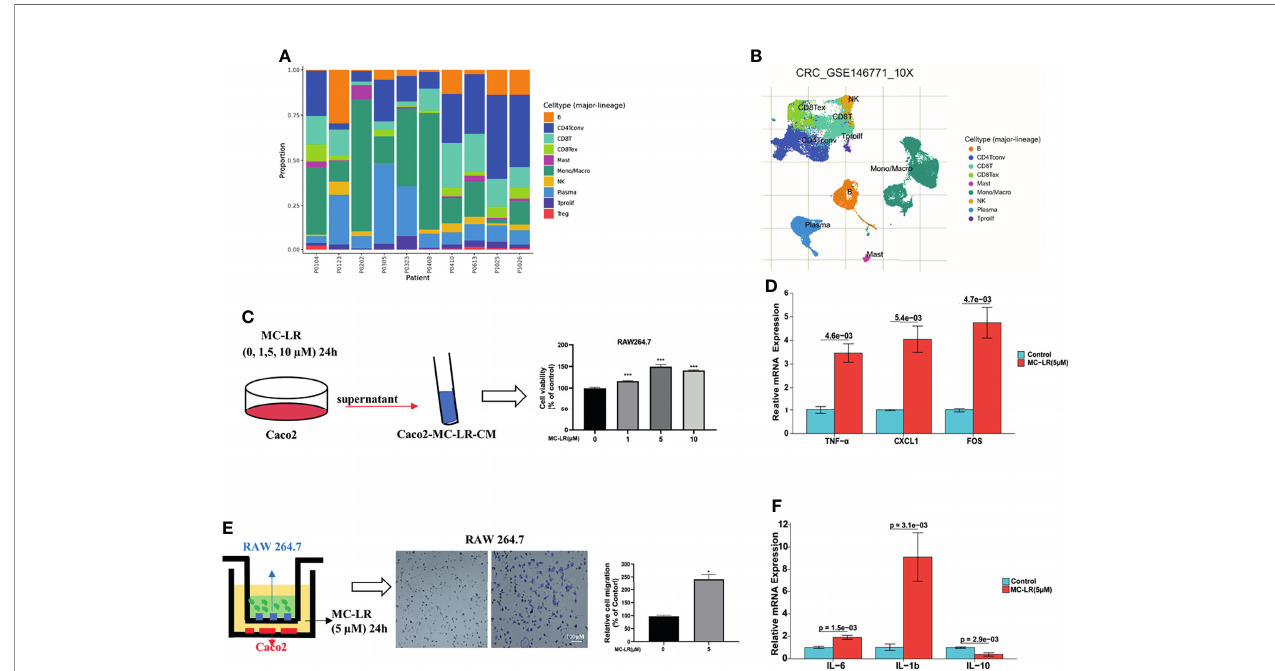
FIGURE 9 | MC-LR-induced interaction between Caco2 and macrophages promoted macrophages proliferation and migration. (A, B) UMAP and bar charts re fl ected the cellular composition of the tumor microenvironment in CRC samples by TISCH. (C) The proliferation of RAW264.7 cells induced by MC-LR with CRC cells through CCK8 assay; *** P <0.001. (D) The migration of RAW264.7 cells were induced by MC-LR with CRC cells through Transwell assay; *P < 0.05 . (E) Under the construction of the cell co-culture system for Caco2 and RAW264.7 cells, the mRNA levels of TNF- a , CXCL1, and FOS in Caco2 cells were measured by q- PCR; (F) Under the construction of the cell co-culture system for Caco2 and RAW264.7 cells, the mRNA levels of IL-6, IL-1b, and IL-10 in RAW264.7 cells were measured by q-PCR. All data are presented as the means ± SEM (n =